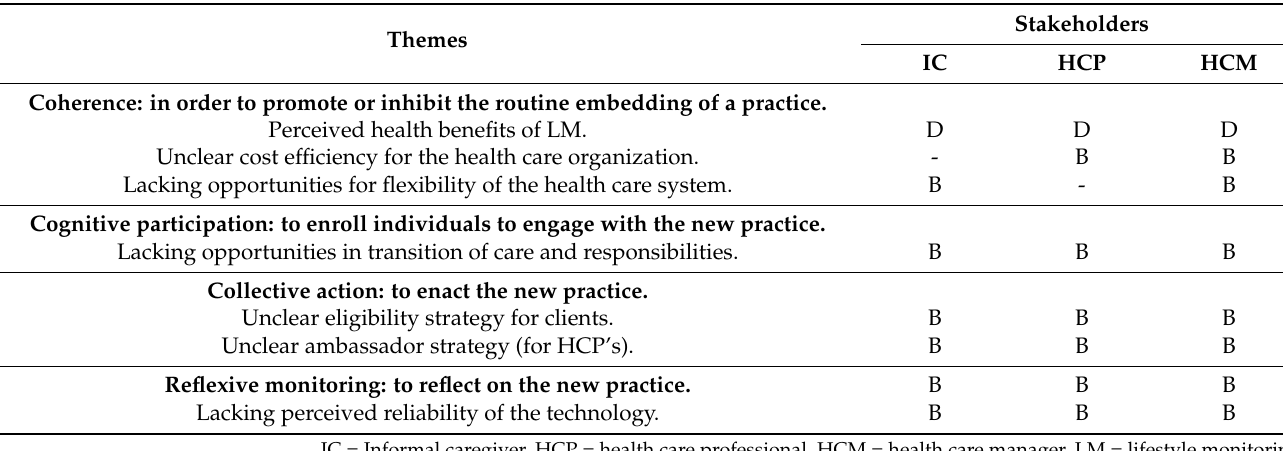
Table 2. Drivers and barriers for implementation within constructs of NPT derived from two or more stakeholder groups. Themes